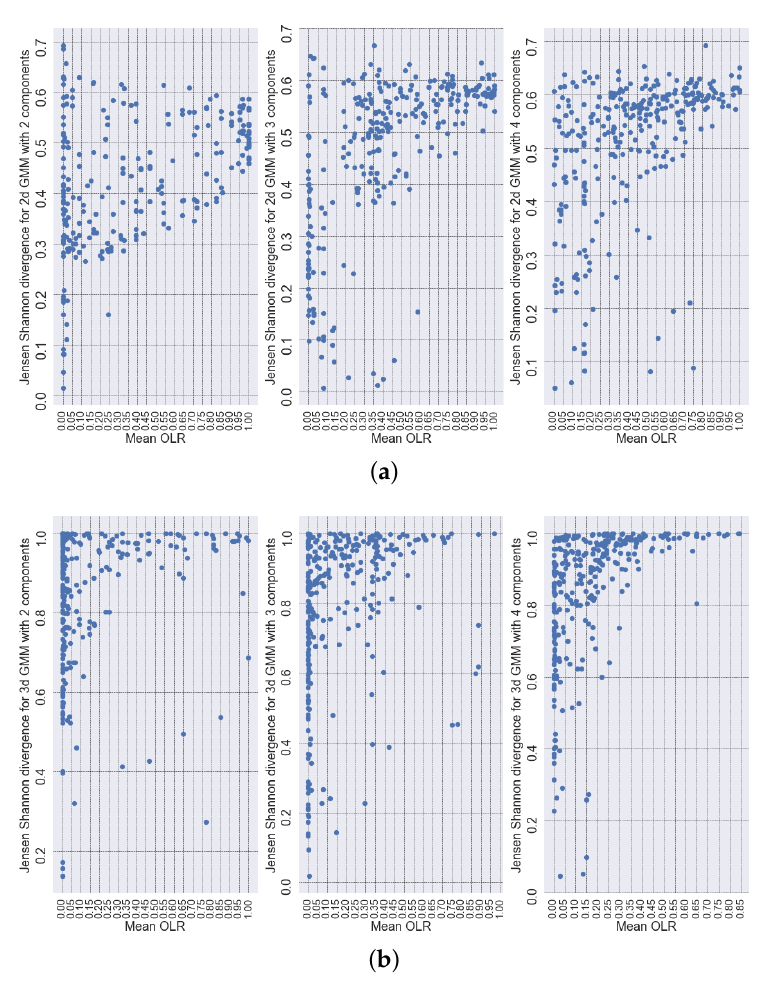
Figure 4. Results of experiments to identify the relationship between the quality of modelling using GMM and the characteristics of the dataset for two-dimensional ( a ) and three-dimensional ( b ) cases with a different number of